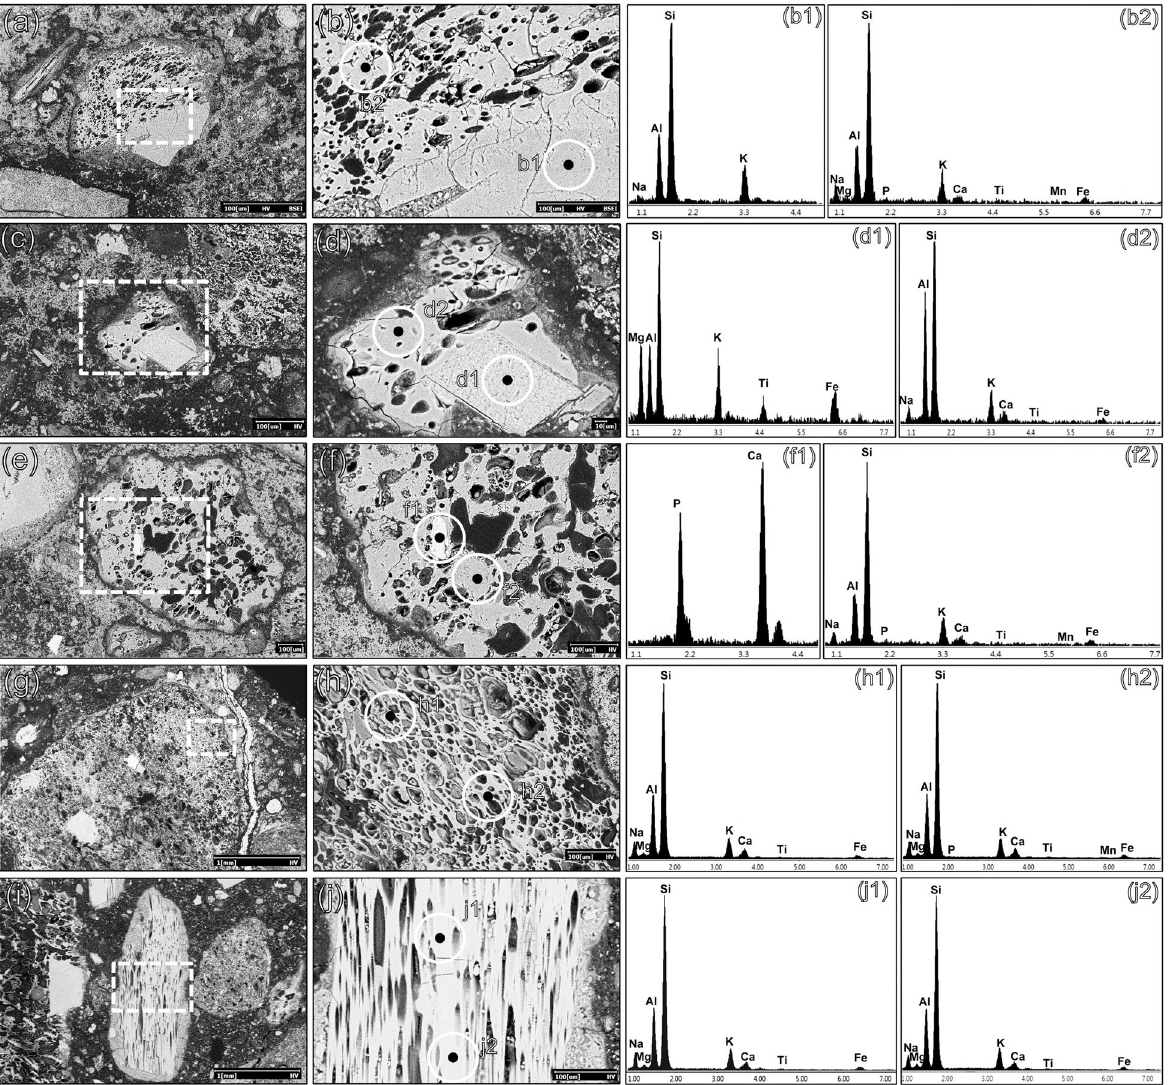
Figure 6. SEM–EDS analyses on representative samples of pumice in sample PREP_25. Backscattered electrons (BSE) acquisitions. ( a ) pumice clast c4 ; ( b ) magnification of the dashed area in fig. ( a ); ( b1 ) EDS spectrum of a K-feldspar phenocryst (sanidine); ( b2 ) EDS spectrum of unaltered volcanic glass; ( c ) pumice clast c5 ; ( d ) magnification of the dashed area in fig. ( c ); ( d1 ) EDS spectrum of a Ti–rich biotite phenocryst; ( d2 ) EDS spectrum of unaltered volcanic glass; ( e ) pumice clast c6 ; ( f ) magnification of the dashed area in fig. ( e ); ( f1 ) EDS spectrum of an apatite phenocryst; ( f2 ) EDS spectrum of unaltered volcanic glass; ( g ) pumice clast g ; ( h ) High-resolution magnification of the dashed area in fig. ( g ); ( h1 , h2 ) EDS spectra of aphyric volcanic glass; ( i ) pumice clast a ; ( j ) High-resolution magnification of the dashed area in fig. ( i ); ( j1 , j2 ) EDS spectra of aphyric volcanic